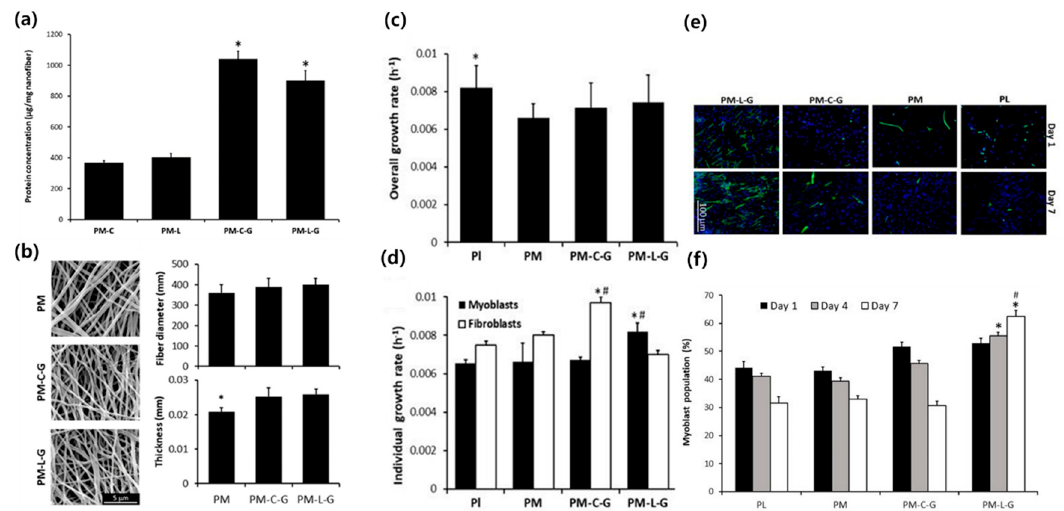
Figure 2. Comparison of the cell growth of the fibroblasts and myoblasts on each type of the nanofiber scaffolds. Abbreviations: Pl, PM, PM-C, PM-L, PM-C-G, and PM-L-G are the plastic surface, PMMA, PMMA-collagen, PMMA-laminin, PMMA-collagen-genipin, and PMMA-laminin-genipin. ( a ) Protein